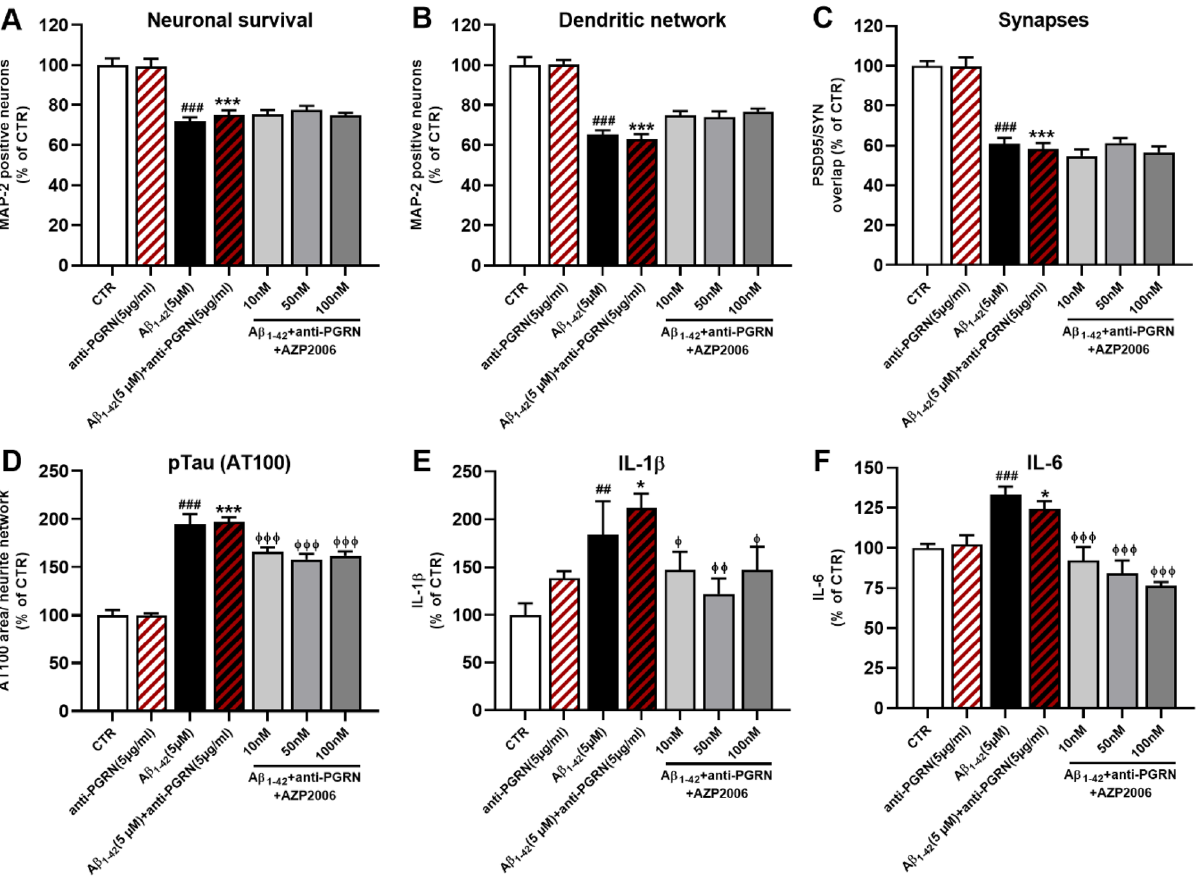
Figure 2. AZP2006/PGRN-induced protection on neuronal survival and morphology. (A , B ) Neuronal cell number and neurite network in mouse cortical neurons intoxicated with Aβ 1-42 oligomers (black bar) and treated with different concentrations of AZP2006 (grey bars) in absence of PGRN (antibody sequestration). MAP-2 staining; CTR (A) = 34.3 positive soma, ± 1.18, n = 6; CTRL (B) = 5883 µm/well ± 239, n = 6). ( C ) Synapses were measured by the overlap of PSD95 and synaptophysin. CTR = 598 µm 2 /well, ± 14.7, n = 6. ( D ) Immunohistochemical quantification of hyperphosphorylated Tau. After AZP2006 treatment, it decreases independently of PGRN sequestration. CTR = 0.34 µm 2 (mean per neurite/well), ± 0.087, n = 6. ( E , F ) IL-1β